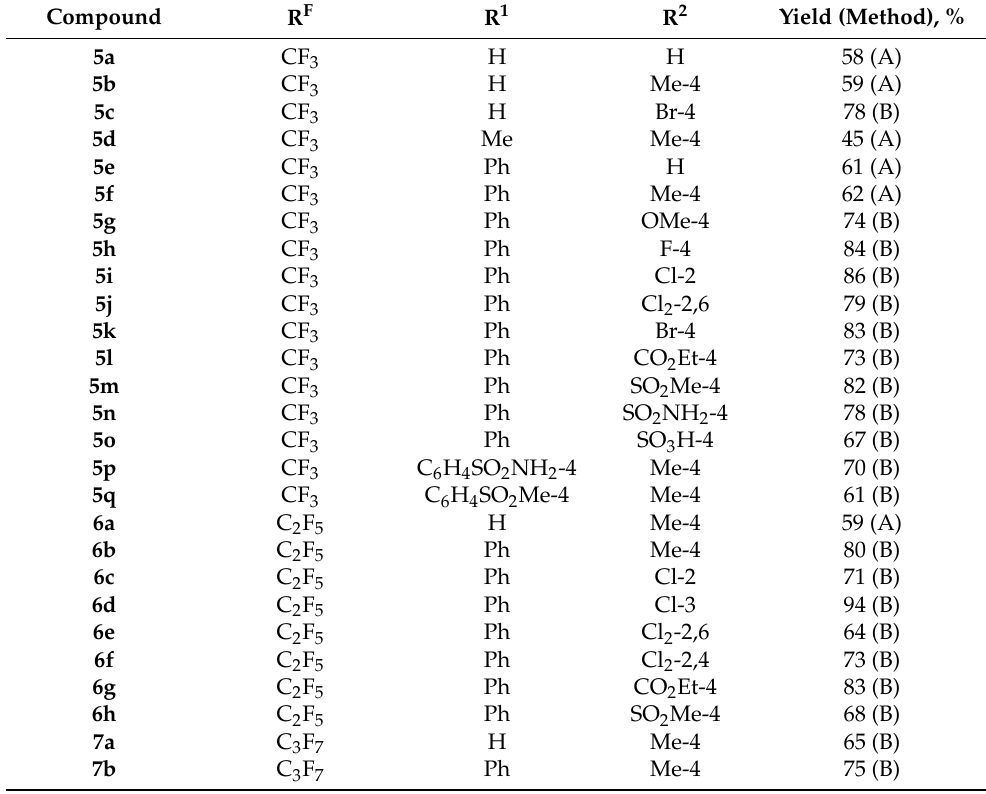
Table 1. Substituents and yields for 4-AHPs 5a – q, 6a – h, 7a,b, 8a,b and 9a,b.